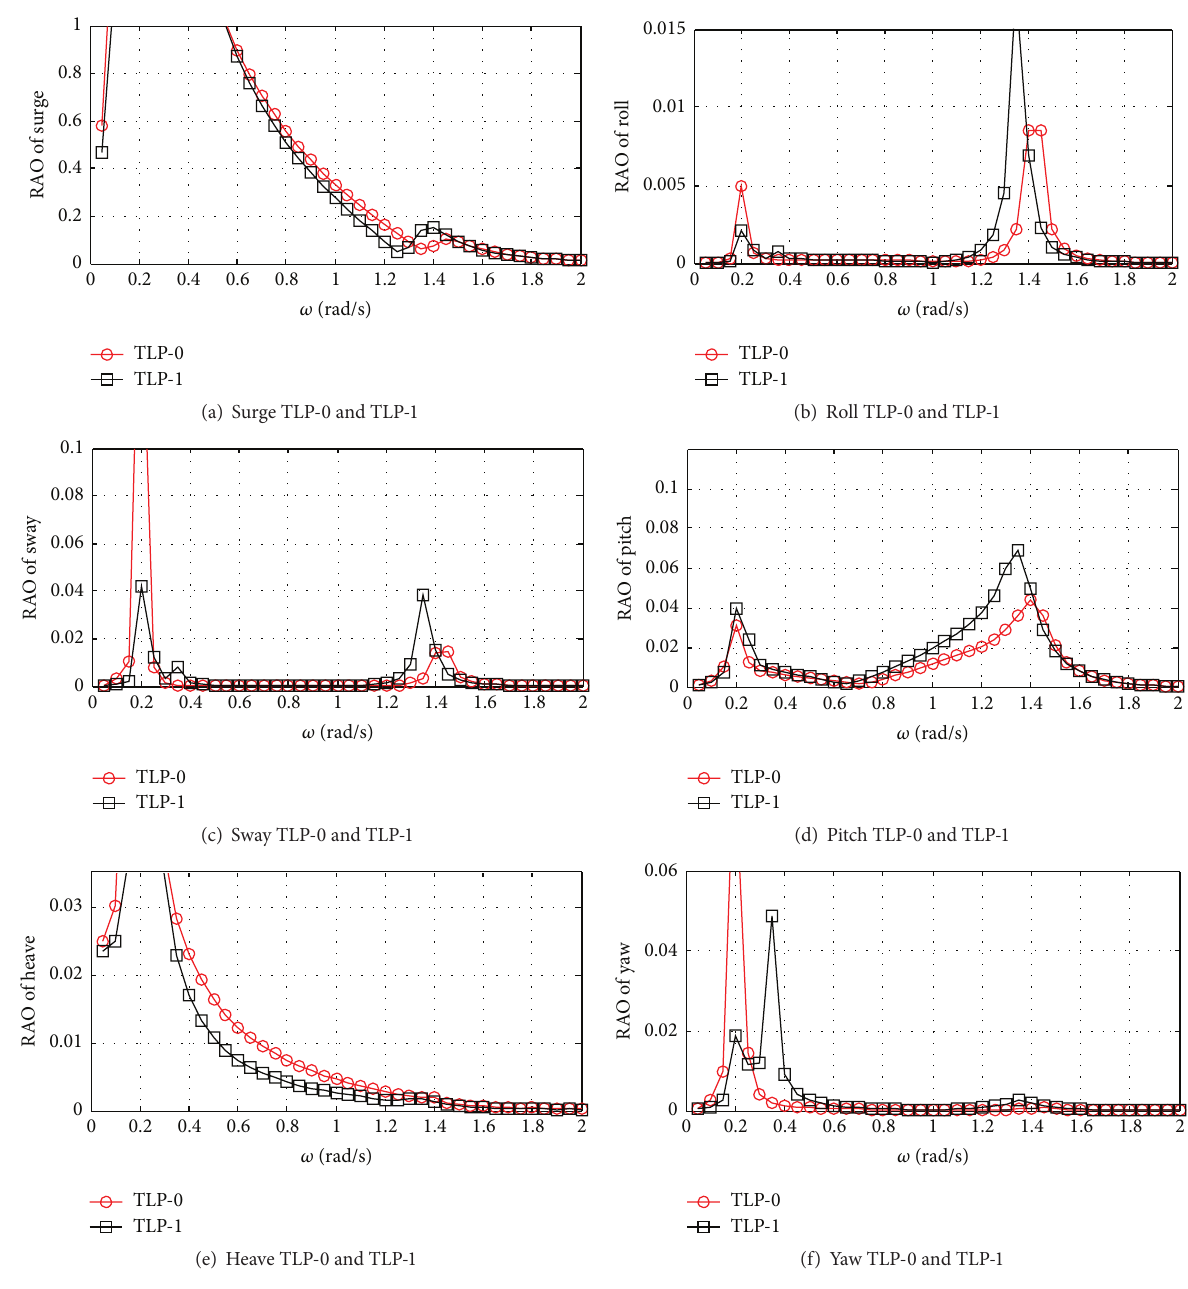
Figure 9: TLP-0 and TLP-1